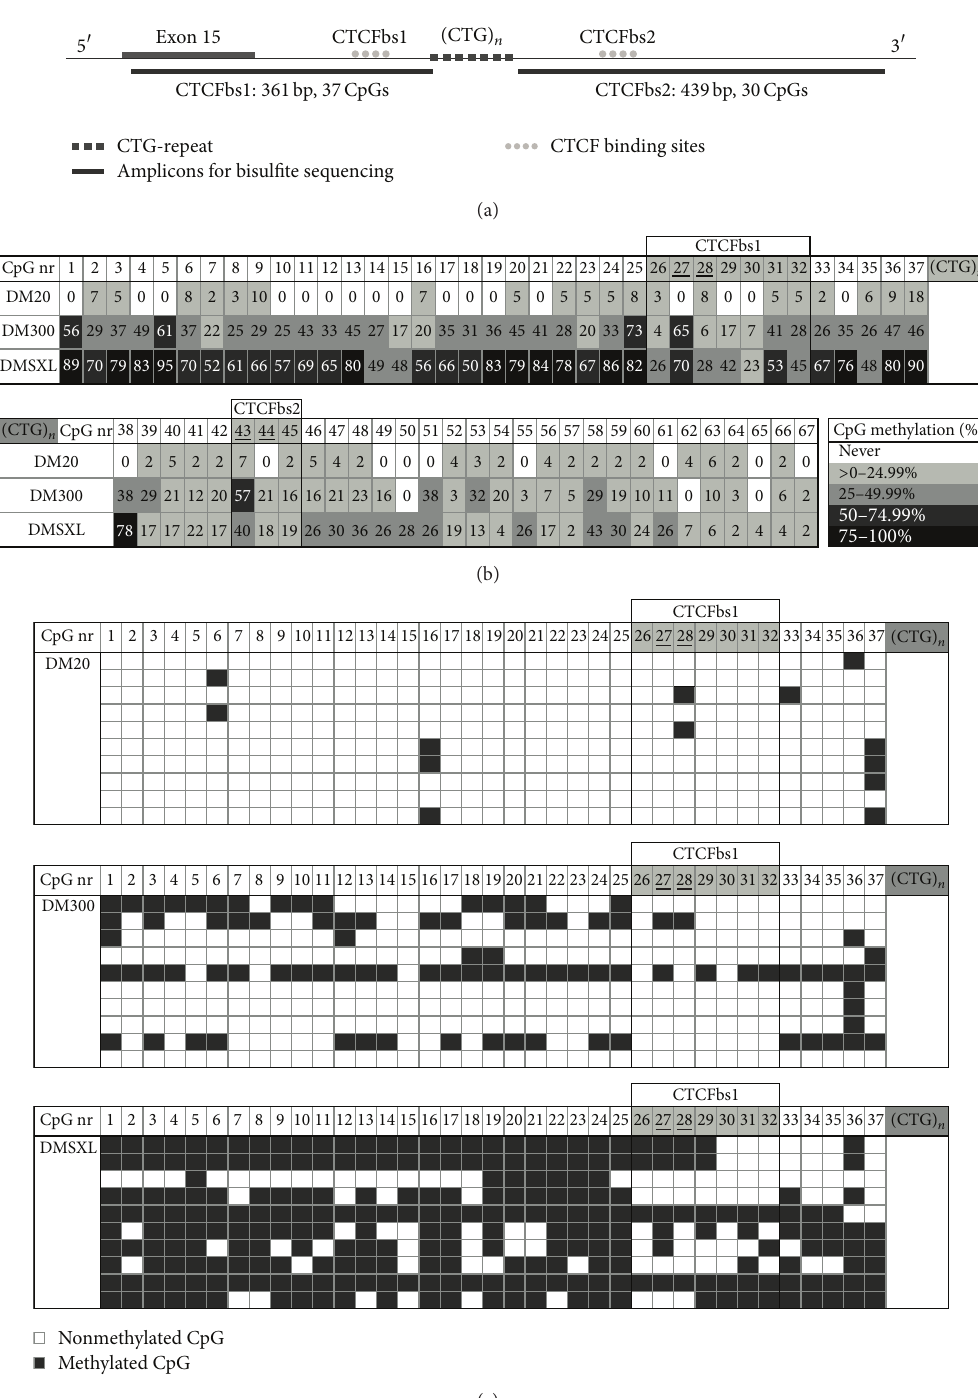
Figure 2: CpG methylation increases with CTG-repeat length. (a) Schematic drawing of the position of the amplicons obtained with seminested PCR, used for bisulfite sequencing, relative to both CTCF-binding sites, the CTG-repeat and exon 15, in the 3 󸀠 region of the DMPK transgene. (b) CpG methylation in hearts of adult mice increases with expanding CTG-repeat length. For each repeat length category, 4 mice were used, and per mouse at least 10 clones were sequenced after bisulfite conversion. CpGs are numbered from 5 󸀠 to 3 󸀠 . Shaded CpG numbers lie within the CTCF-binding site recognition sequence. Underlined CpG numbers are CpG dinucleotides that contain G residues essential for recognition by CTCF [19]. Numbers indicate the weighted average percentage of methylation at a particular CpG, seen across all clonesinall4mice.ColourcodingfurtherindicatestheapproximatedegreeofmethylationatagivenCpG.(c)Exampleofmethylationprofiles obtained in different clones, representing different cardiac cells of 1 mouse per repeat length category. Individual clones show substantially distinct methylation